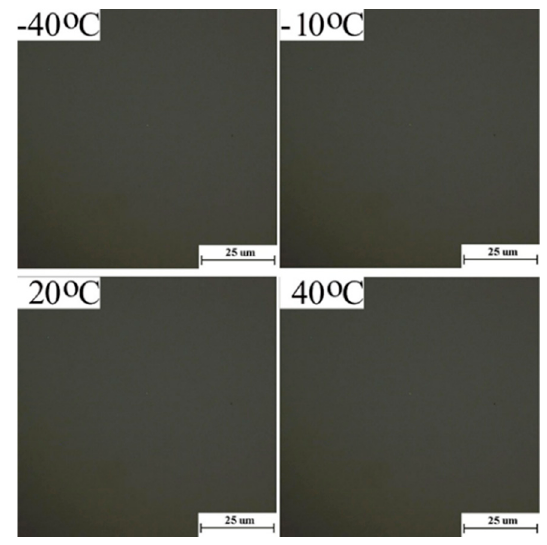
Figure 3. POM snapshots of elastomer S1 at different temperatures.